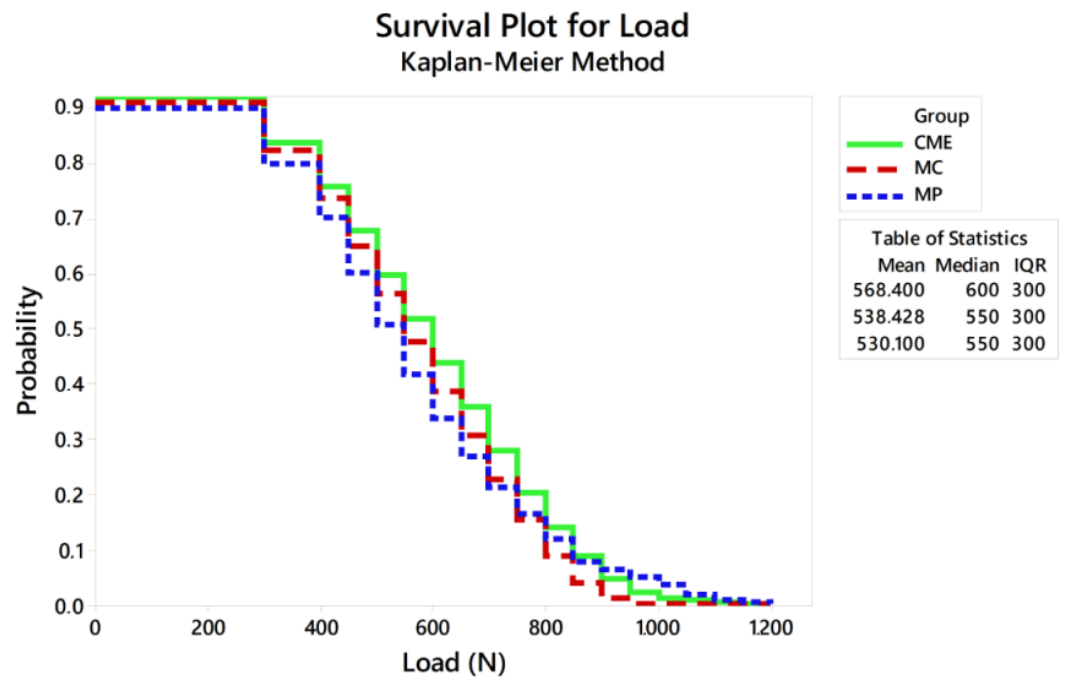
Figure 7. Survival plot using the Kaplan–Meier method. Table 2. Crowns survival in fatigue at different load missions. Table 3. Weibull modulus ( m ), characteristic strength ( σ ), and confidence intervals. The statistical di ff erences were determined based on the confidence interval